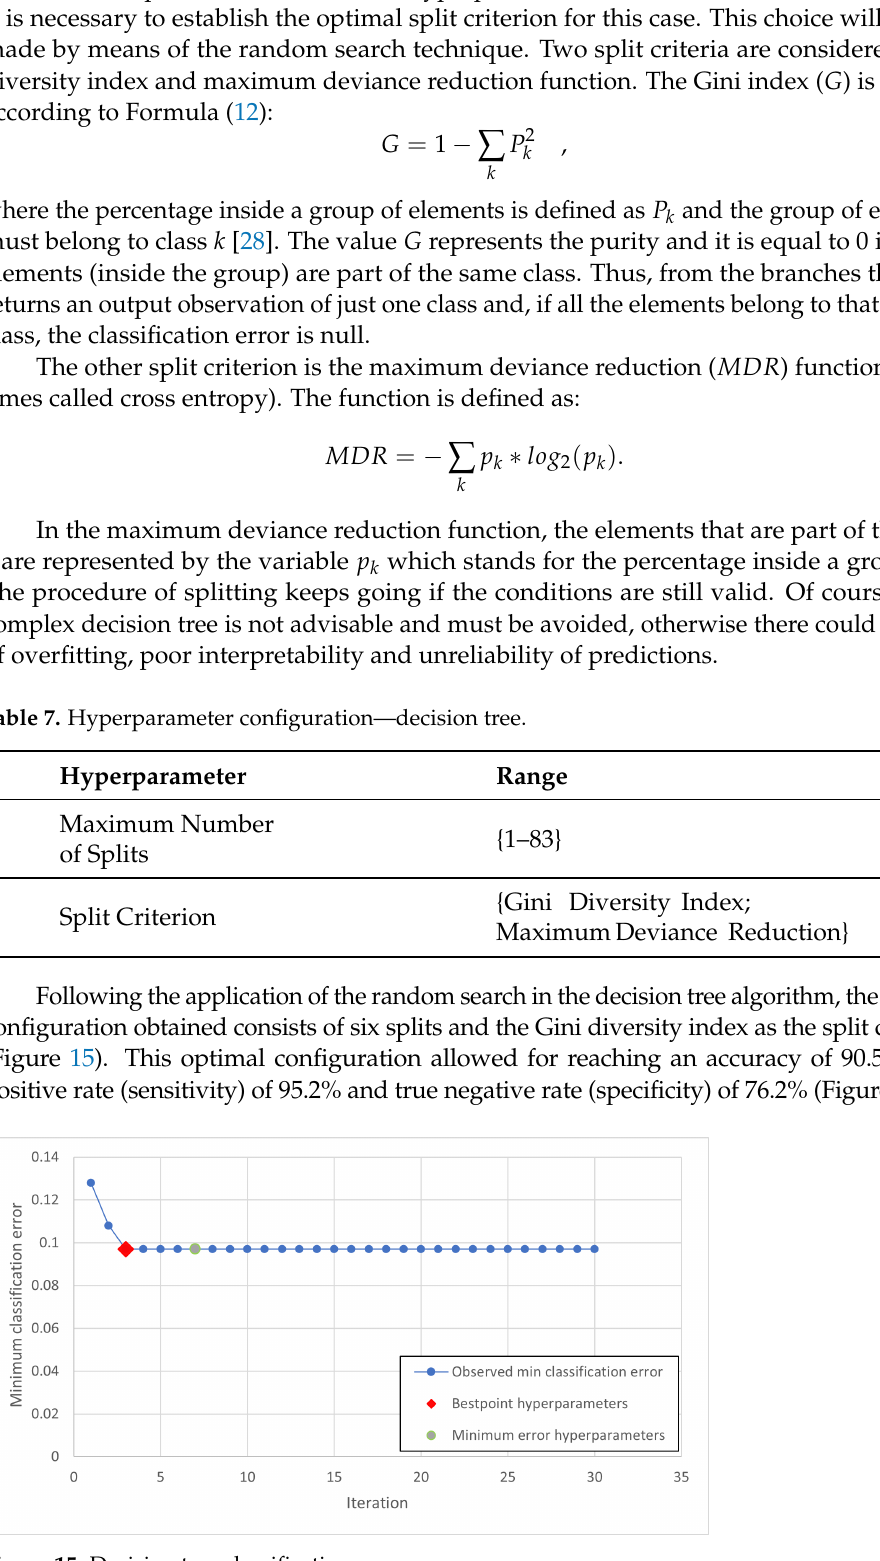
Figure 15. Decision tree classification